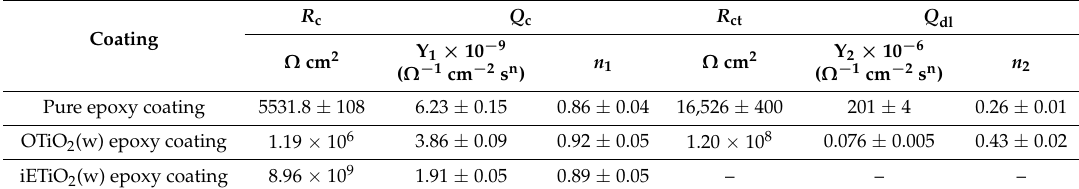
Table 2. Fitting parameters to simulate the EIS data of the pure epoxy coating, OTiO 2 (w) epoxy